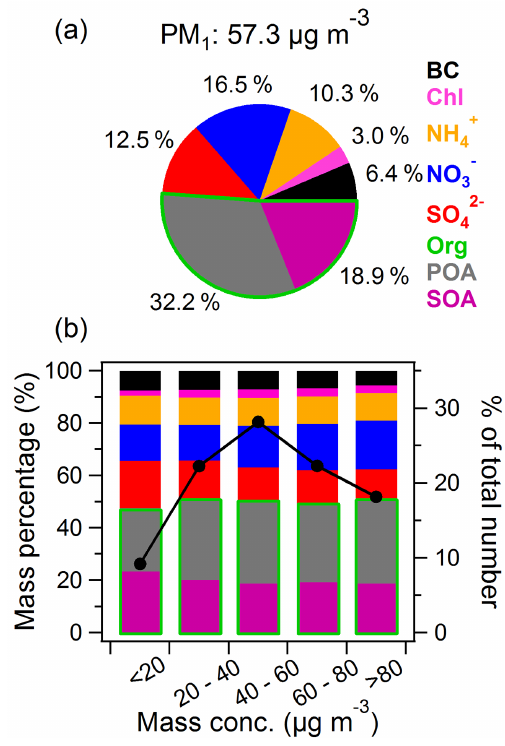
Figure 2. The average mass contribution of PM 1 ( = NR- PM 1 + BC) species (a) during the whole sampling period and (b) as a function of the PM 1 mass concentration (µgm − 3 ) bins (left). The right axis in (b) shows the percentage of the data number in each bin to the total data number. The organics were decomposed into primary organic aerosol (POA) and secondary organic aerosol (SOA) using PMF (Sect.